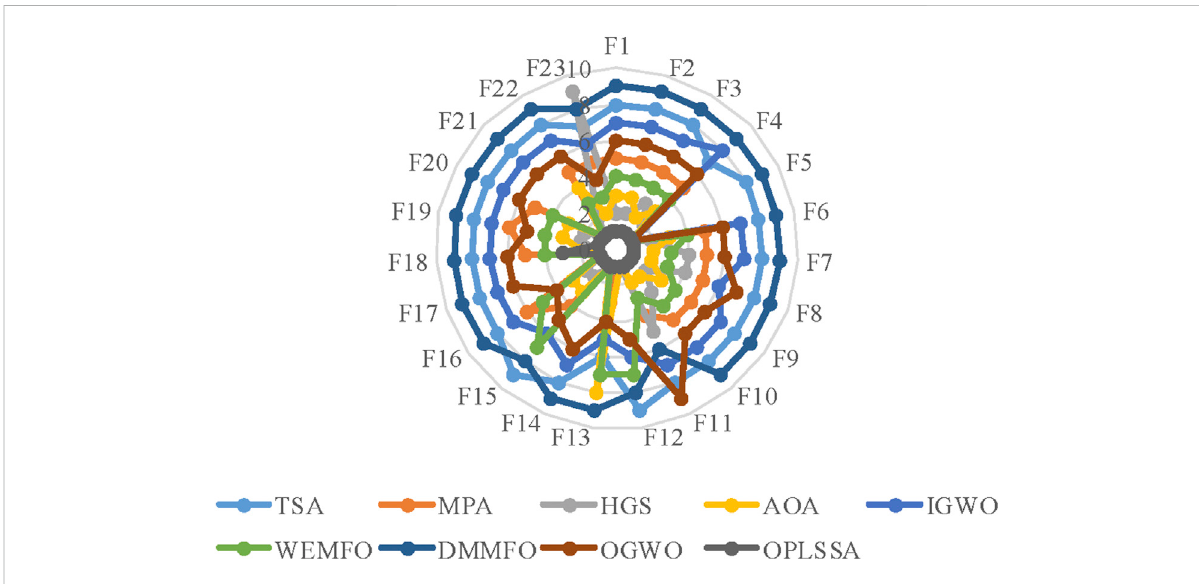
FIGURE 6 Radar plot for consolidated ranks of 23 benchmark problems with OPLSSA and the Frontier